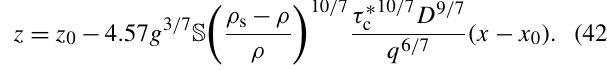
Figure 2. When d z/ d t = U , the analytical solution for an equilibrium-width river (Eq. 40) matches the numerical solution for an equilibrium-width river (Eq. 36). Equation (36) is derived from the general equation for an equilibrium-width river, Eq. (20), to in- clude power-law downstream relationships for valley width and wa- ter discharge (Eqs. 31–35). Here, the slope at the upstream bound- ary condition is S 0 = 0 . 015; this is set to produce an input bed-load = 3 . 48 × 10 − 4 m 3 s − 1 . Water discharge, sediment discharge of Q s 0 Q = 1 . 43 × 10 − 5 x 49 / 40 m 3 s − 1 ; drainage area, A = x 7 / 4 m 2 , and valley width, B = 25 x 1 / 5